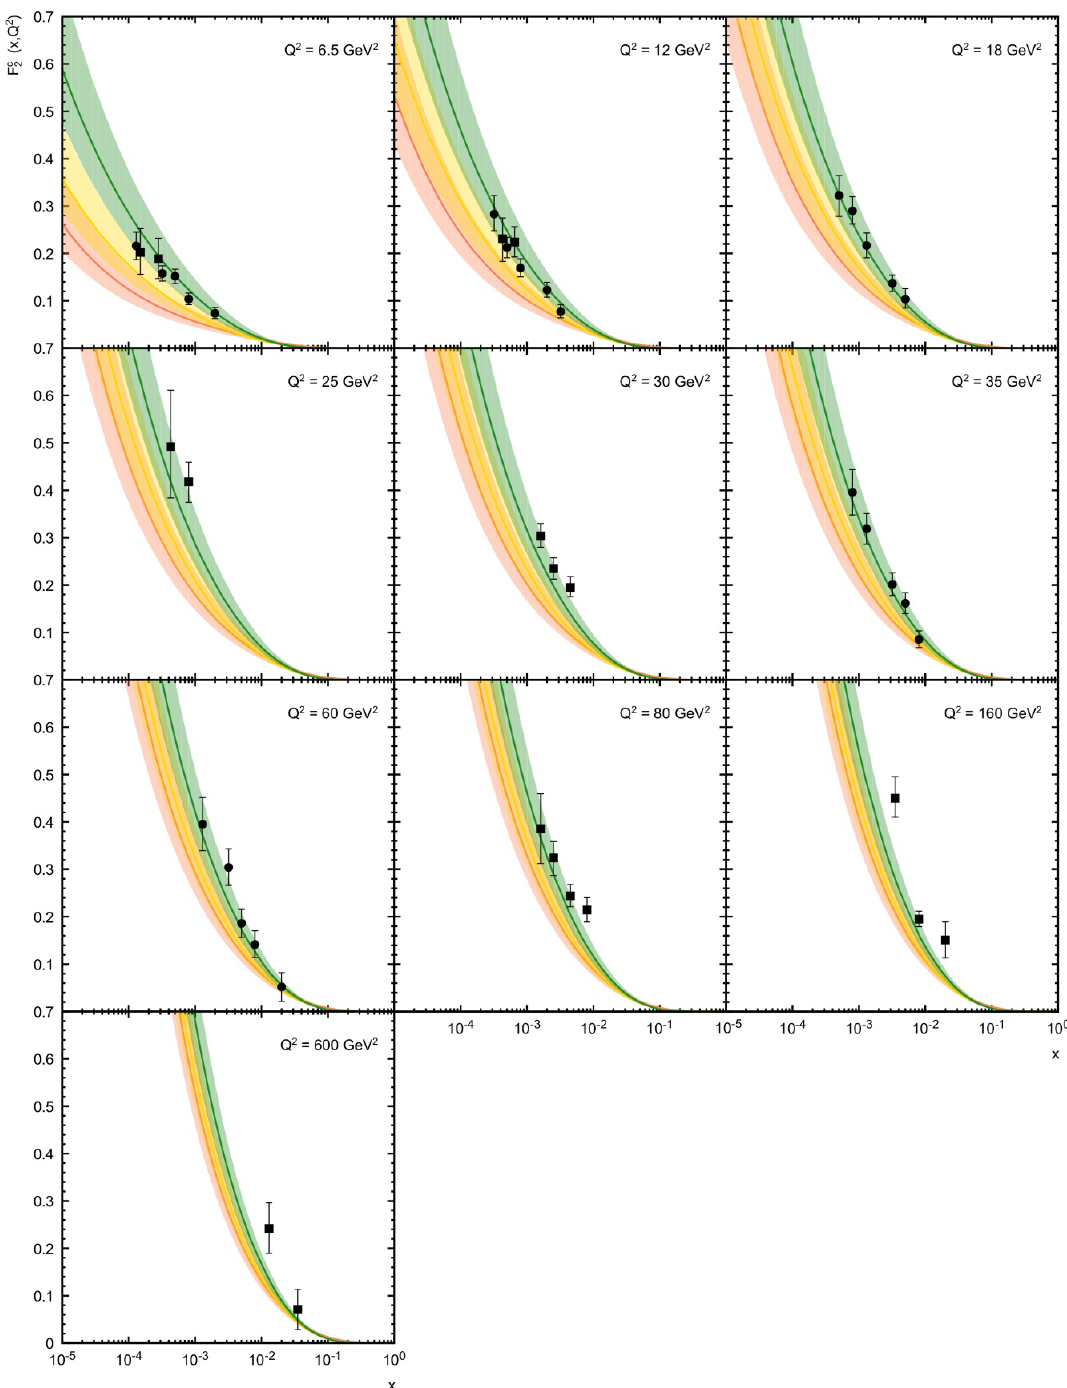
Figure 8 . The charm contribution to the proton structure function F 2 ( x; Q 2 ) as a function of x calculated at di(cid:11)erent Q 2 . Notation of curves is the same as in (cid:12)gure 1. The experimental data are from ZEUS [99] and H1 [100].